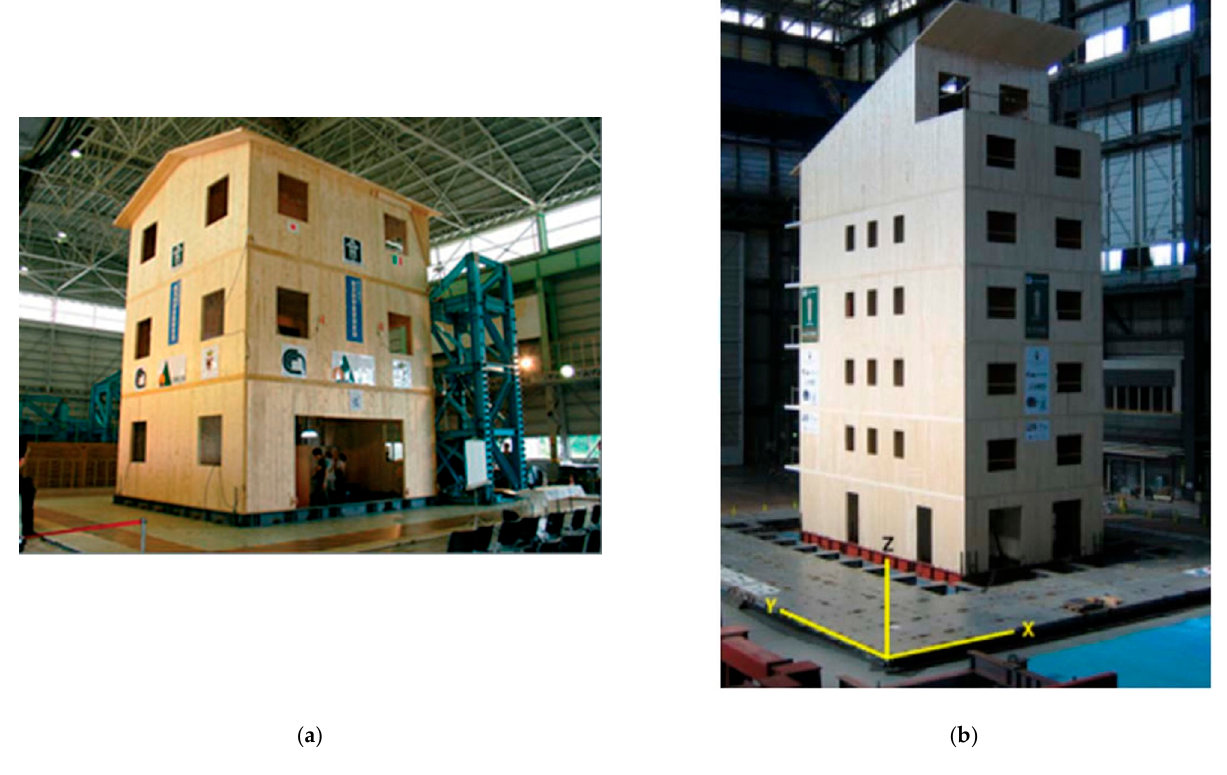
Figure 2. ( a ) The three-storey [17] and ( b ) seven-storey CLT buildings [16] tested in the SOFIE project.